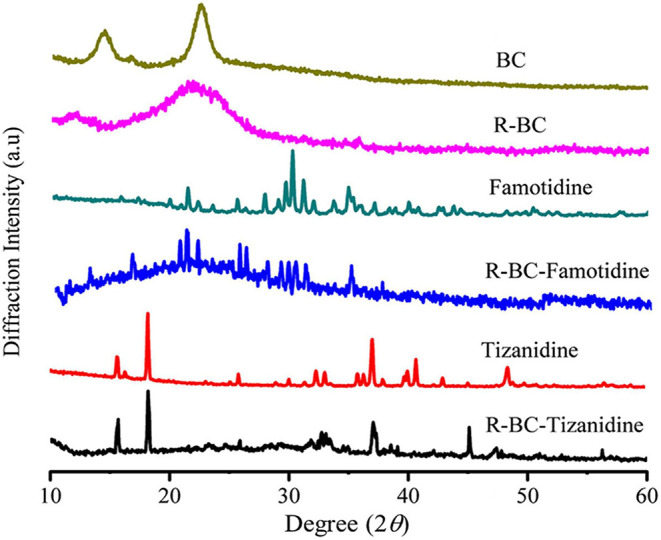
XRD pattern of R-BC, famotidine, R-BC-famotidine, tizanidine, and R-BC-tizanidine.